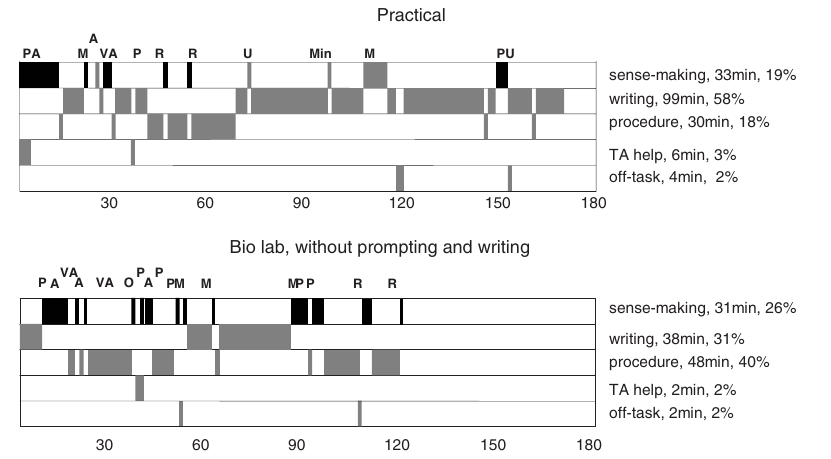
FIG. 5. Time lines for the practical exam and for